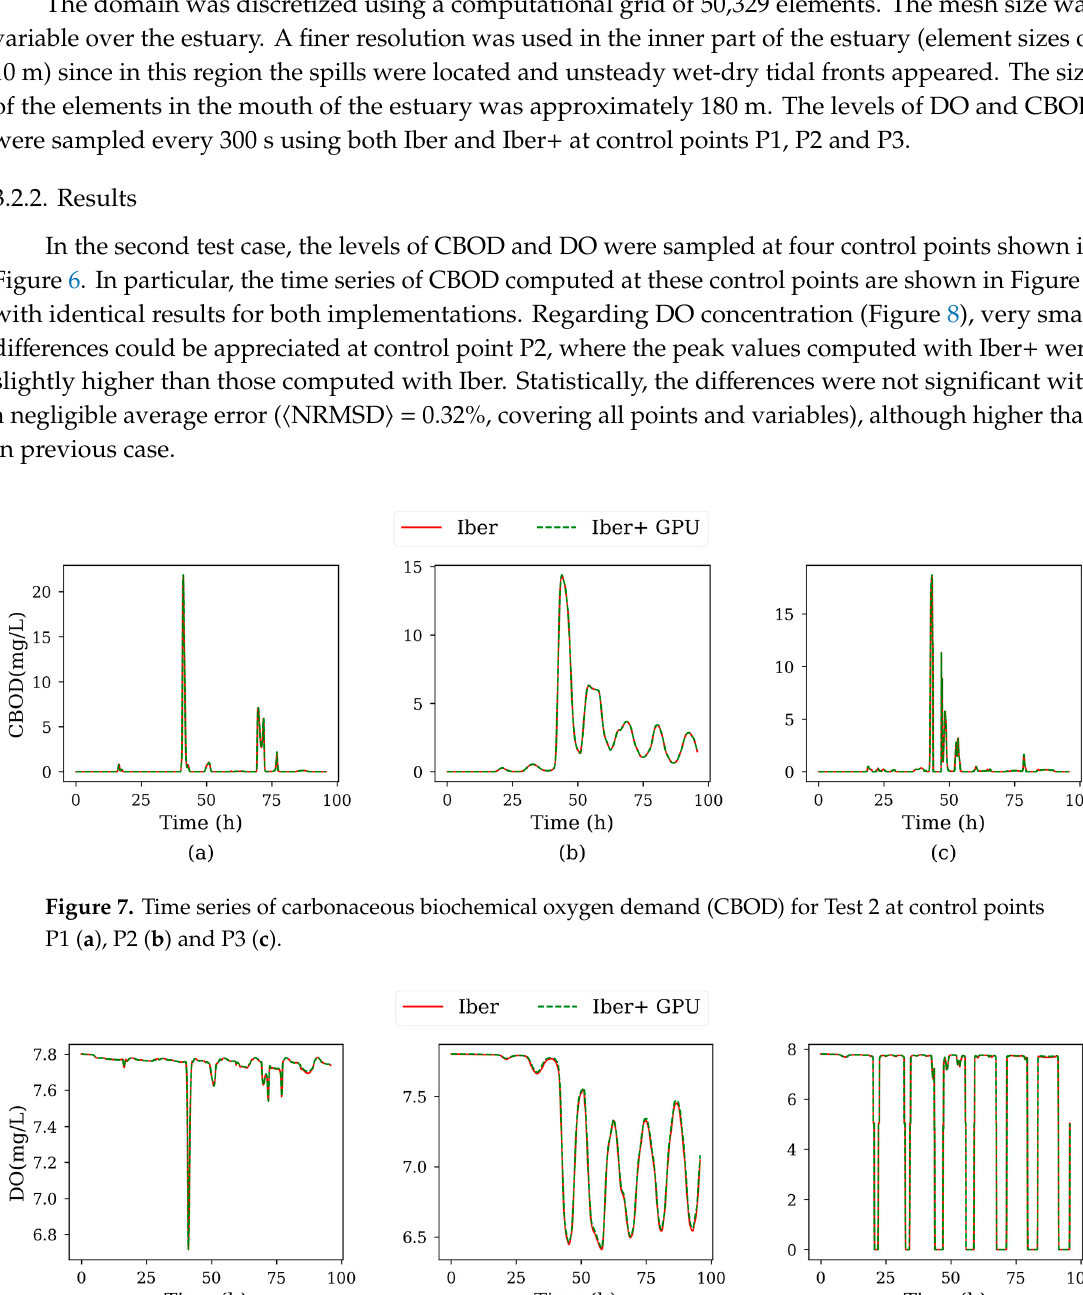
Table 2. Performance measurements obtained for the second test case (estuary of A Coruña). Model